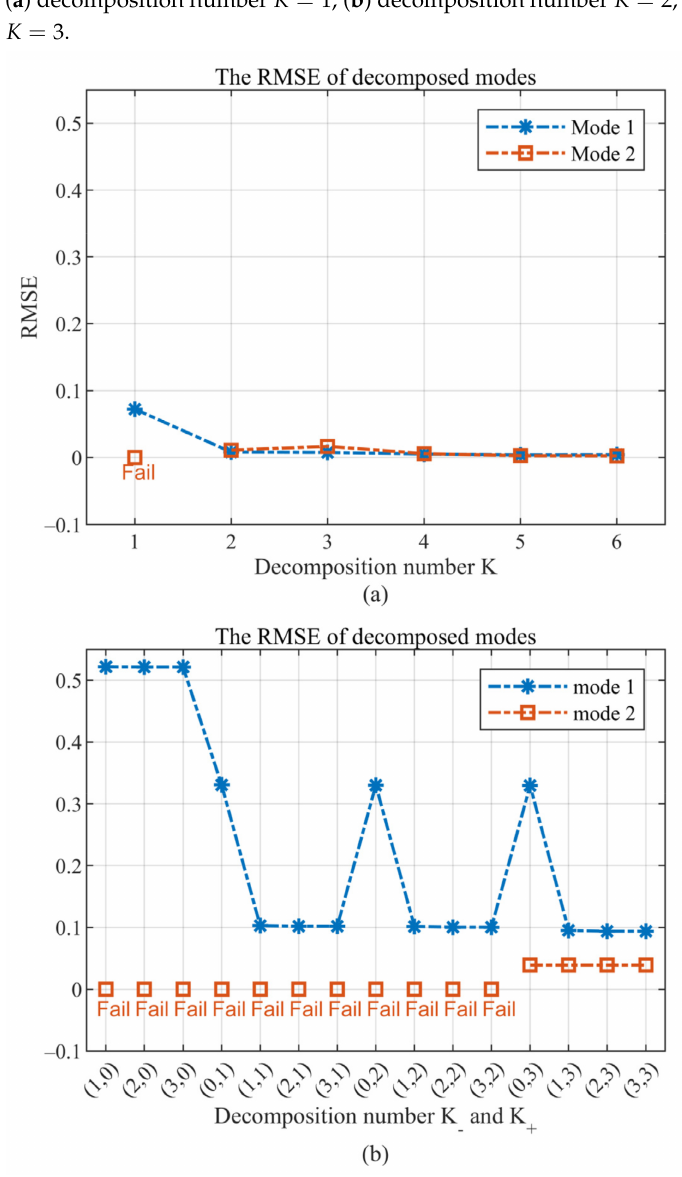
Figure 8. The RMSE of mode 1 (blue line) and mode 2 (red line) versus the decomposition number: ( a ) MCVMD results and ( b ) CVMD